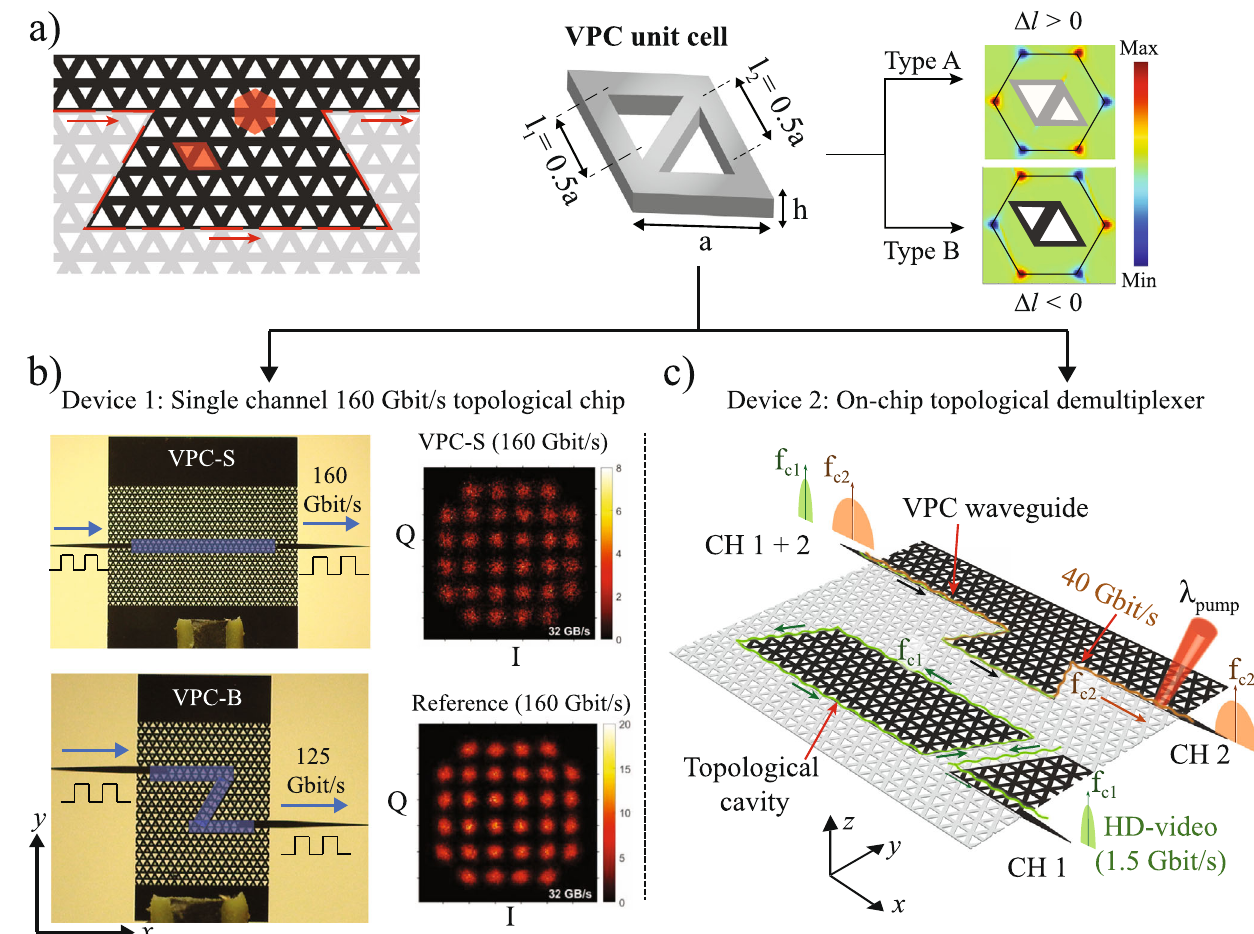
Fig. 1 | Phototunable on-chip THz topological devices for 6G communication. a Schematic of the topological interface showing two topologically distinct regions (black and gray regions). The domain wall is highlighted with a red dash line that hosts robust propagation of THz waves even at sharp bends. The red shaded regions show Wigner-Seitz and unit cell (rhombus-shaped). The central portion depicts the unit cell of VPC where the side of equilateral triangular air holes are marked with l 1 and l 2 , respectively. The sign of Δ l = l 1 − l 2 differentiate the Type A ( Δ l >0) and Type B ( Δ l <0) unit cells. The right panel shows the numerically calculated distribution of Berry curvature for both the unit cells. The Berry curvature is localized near the K and K ′ valley, and Type A and Type B unit cells exhibit complementary distribution. b Optical image of fabricated straight (VPC-S) and bend (VPC-B) Si-VPC chips. An adiabatic tapered couplers were designed at both the input and output facets to ef fi ciently in and out couple the THz waves from Si-VPC chips. The domain wall in Si-VPC chip is highlighted with a blue shaded region. The highest data rate recorded through VPC-S and VPC-B chips is160Gbit/s and 125Gbit/s, respectively. Insetshowsthe